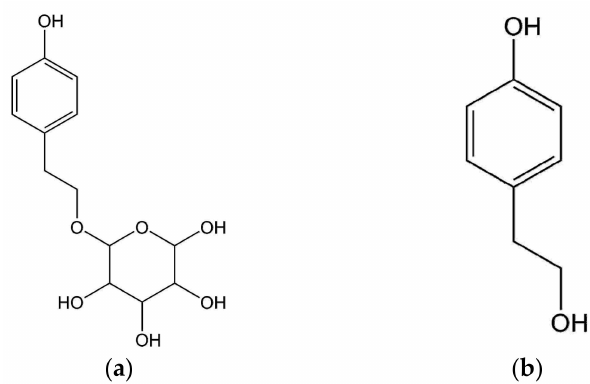
Figure 1. Chemical structure of salidroside and p -tyrosol. ( a ) salidroside; ( b ) p